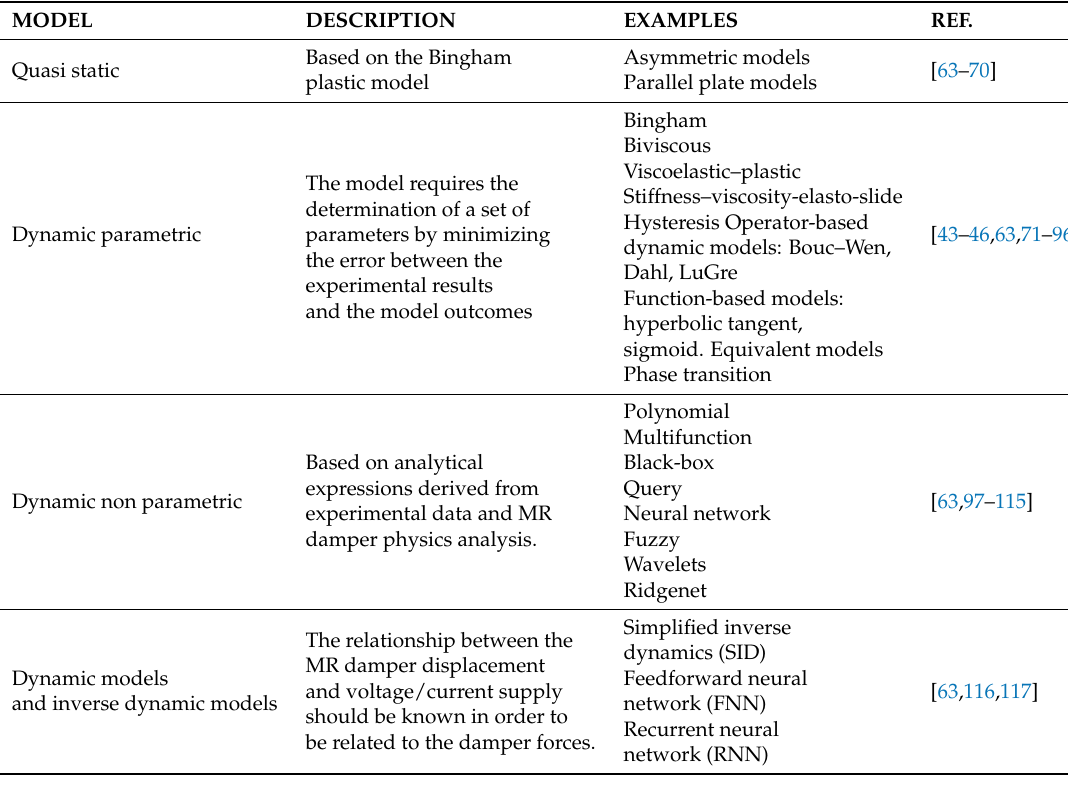
Table 4. MR dampers models